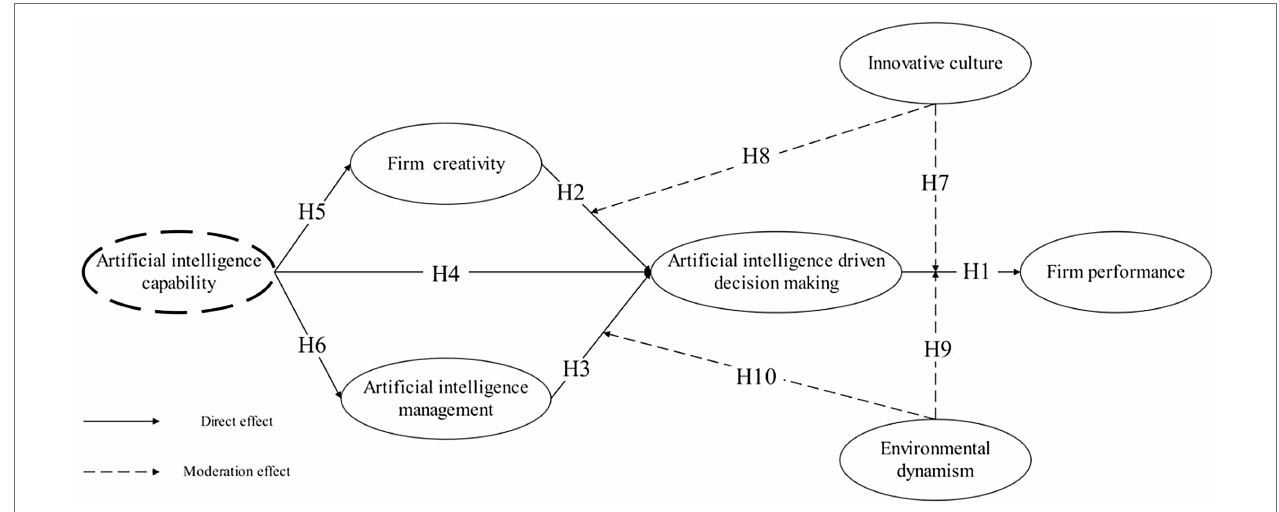
FIGURE 2 | Conceptual